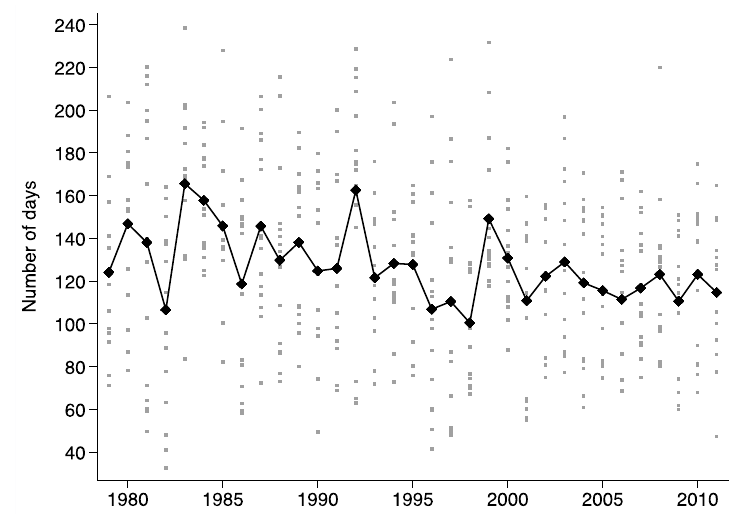
Figure 7. Based on our estimation of the monsoon period, this graph shows the average date of the onset and retreat of the monsoon in the 15 provinces in China where tea is grown over the study period (1980–2011).